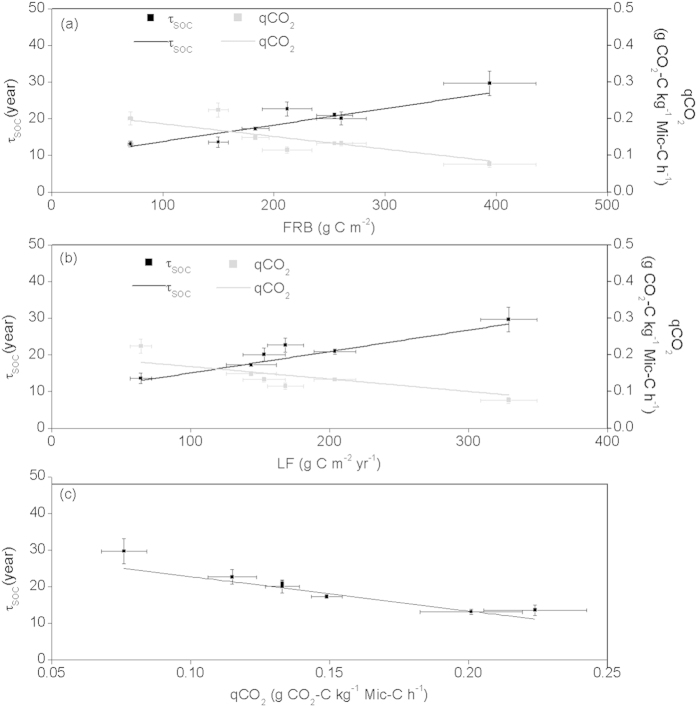
Linear regression between (a) fine root biomass (FRB) and mean residence time of SOC (τSOC) (τSOC = 0.045FRB + 9.33, R2 = 0.88, p = 0.001, n = 7), and microbial metabolic quotient (qCO2) (qCO2 = −0.00034FRB + 0.22, R2 = 0.68, p = 0.014, n = 7); between (b) litterfall (LF) and τSOC (τSOC = 0.058LF + 9.24, R2 = 0.86, p = 0.005, n = 6), and qCO2 (qCO2 = −0.00034LF + 0.20, R2 = 0.58, p = 0.048, n = 6); and between (c) qCO2 and τSOC (τSOC = −30.5qCO2 + 35.8, R2 = 0.92, p < 0.001, n = 7). The error bars represent standard errors [n = 3 (plots)].